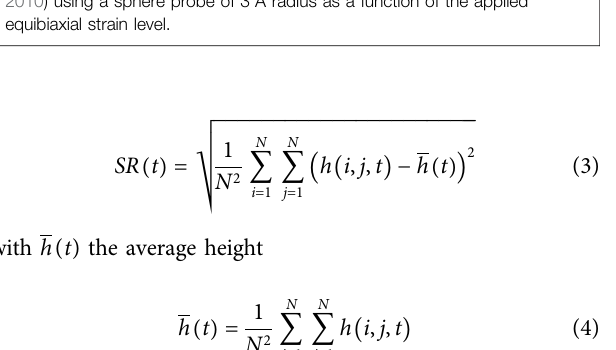
FIGURE 5 | Average distance between free surfaces located by the alpha-shape algorithm (Stukowski, 2014) implemented in Ovito (Stukowski, 2010) using a sphere probe of 3 Å radius as a function of the applied equibiaxial strain level.